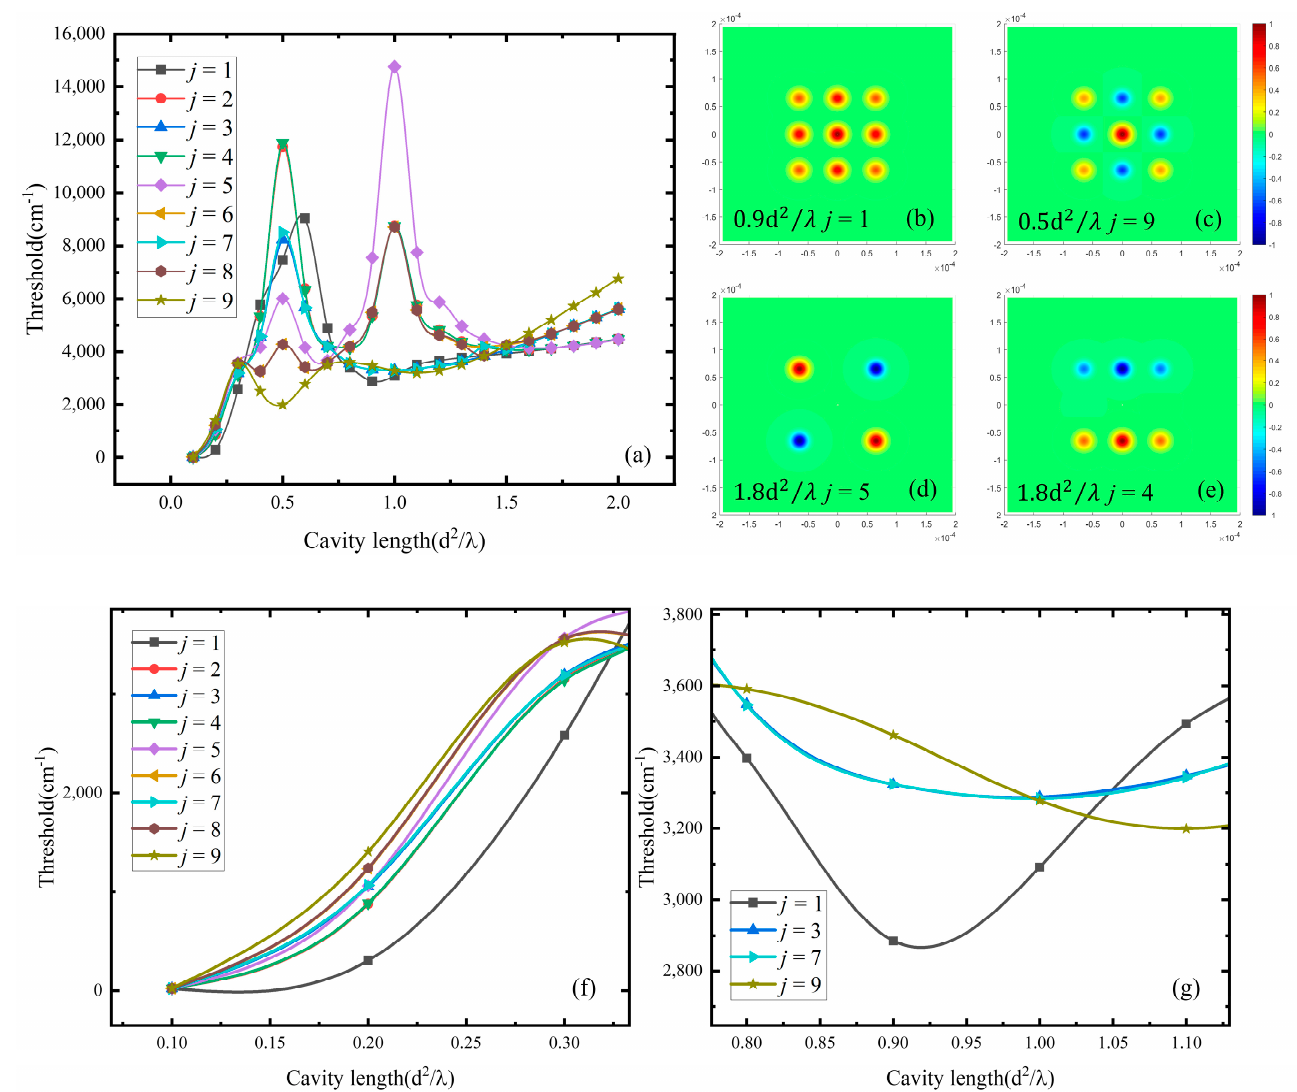
Figure 2. ( a ) Gain thresholds of each order supermode obtained by parallel-coupled calculation of the external cavity diffraction of the square array composed of TEM 00 transverse mode elements with the duty ratio F = 0.4; ( b ) the lowest order mode’s near-field distribution ( j = 1); ( c ) the highest mode’s near-field distribution ( j = 9); ( d ) the intermediate supermode’s near-field distribution ( j = 5); ( e ) the intermediate supermode’s near-field distribution ( j = 4); ( f ) enlarged view of the part of 0.1 − 0.3 d 2 / λ ; ( g ) enlarged view of the part of 0.8 − 1.1 d 2 / λ